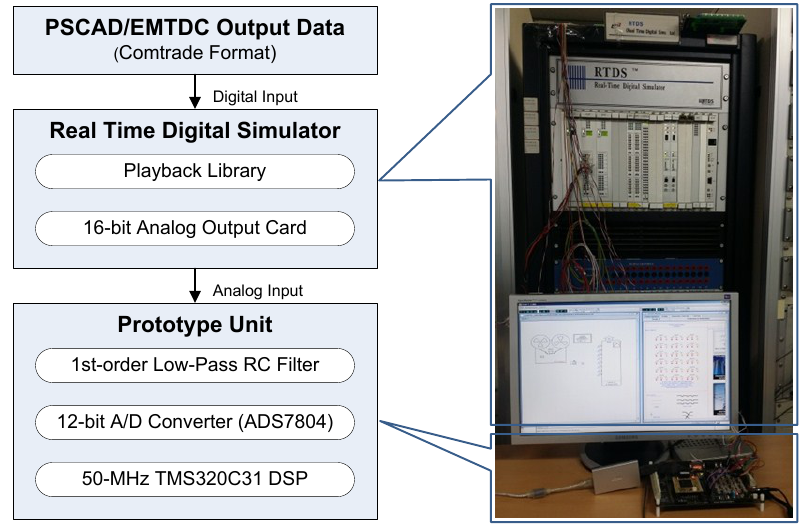
Figure 8. Hardware